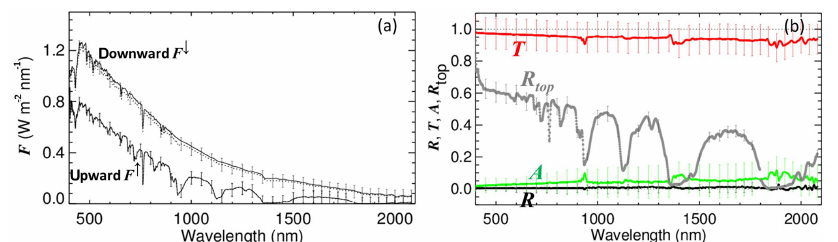
Figure 7. (a) The measured, averaged, spectral downward and upward irradiance F from the aircraft above the cloud layer (solid lines) and AIRTOSS below the cloud layer (dotted lines) at the time period, indicated by the vertical dashed lines in Fig. 6. F Panel (b) shows spectral reflectivity (black), transmissivity (red), absorptivity (green), and cloud top albedo (gray) according to irradiance in (a) . The vertical bars indicate the systematic errors due to measurement uncertainties.